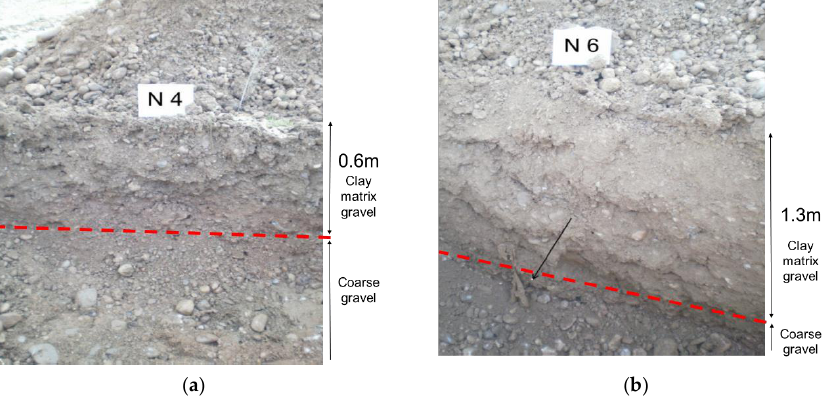
Figure 6. ( a ) Detail of trial pit N4, and ( b ) detail of trial pit N6. Both are excavated in the infiltration pond of Ca n’ Albareda. Water 2020 , 12 , x FOR PEER REVIEW